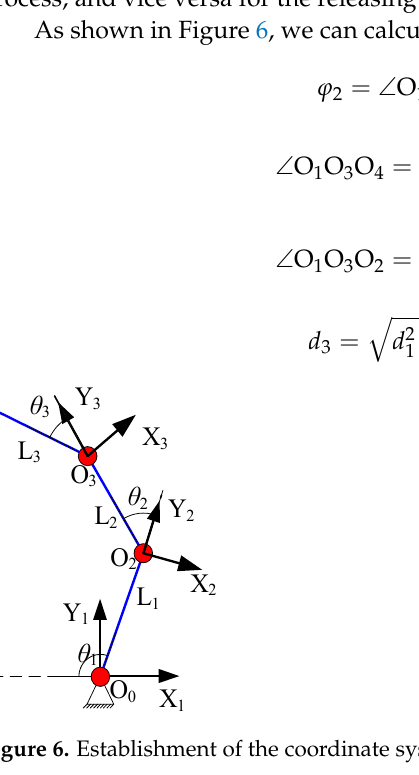
The functional relationship between ϕ 2 and ϕ 1 is established through Equations (1)–(4),